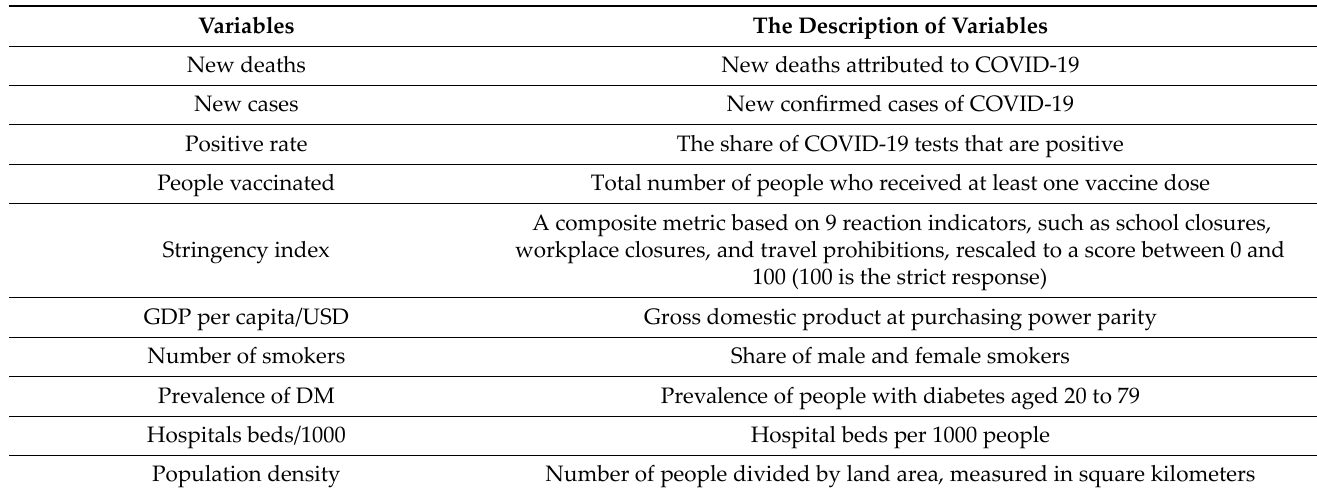
Table 1. The target variable and input variables for this